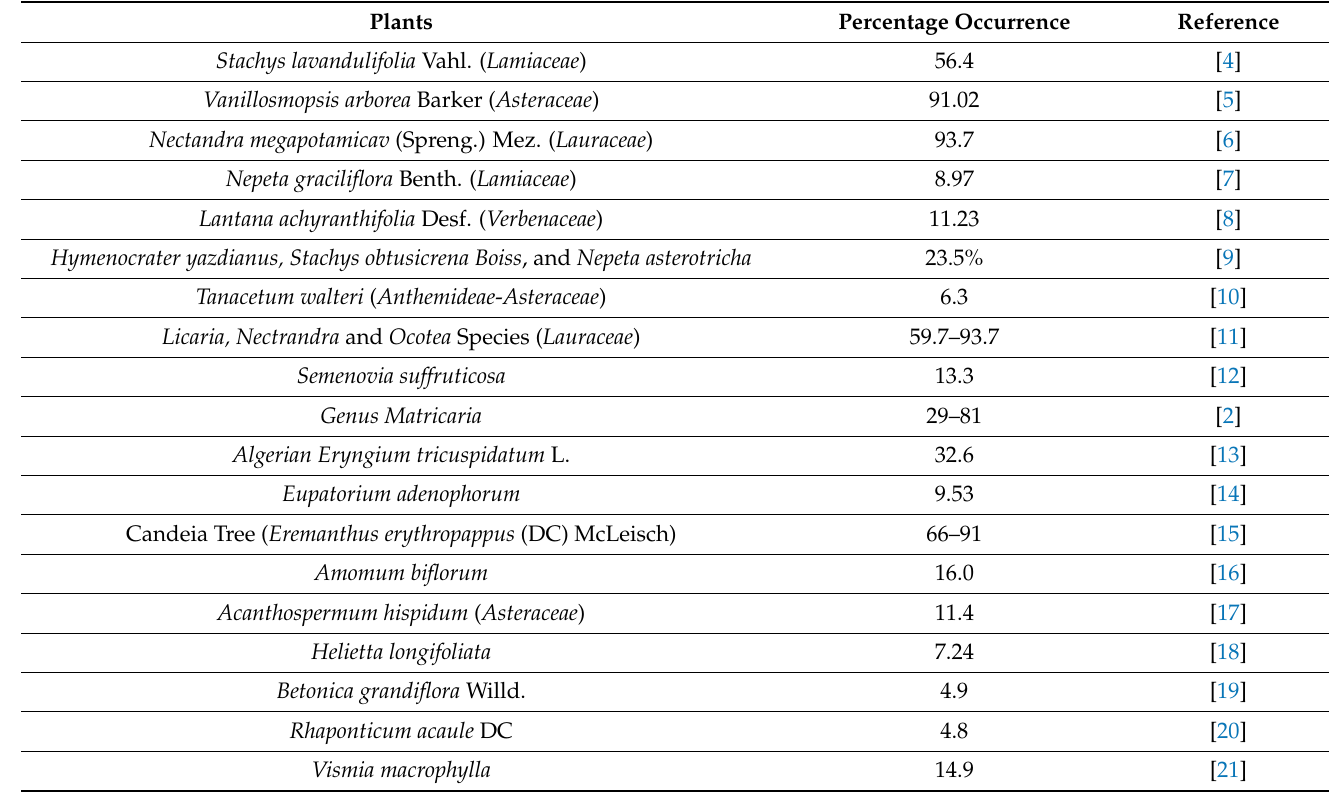
Table 1. Percentage occurrence of α -Bisabolol in different